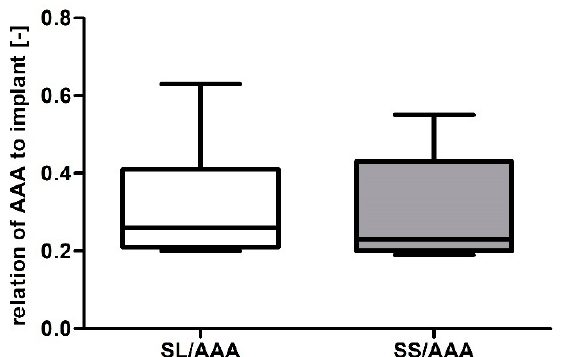
Figure 5. Bar chart representation of relation between aneurysm and stent-graft for abdominal aortic aneurysm (AAA), long stent-graft (SL), and short stent-graft (SS).